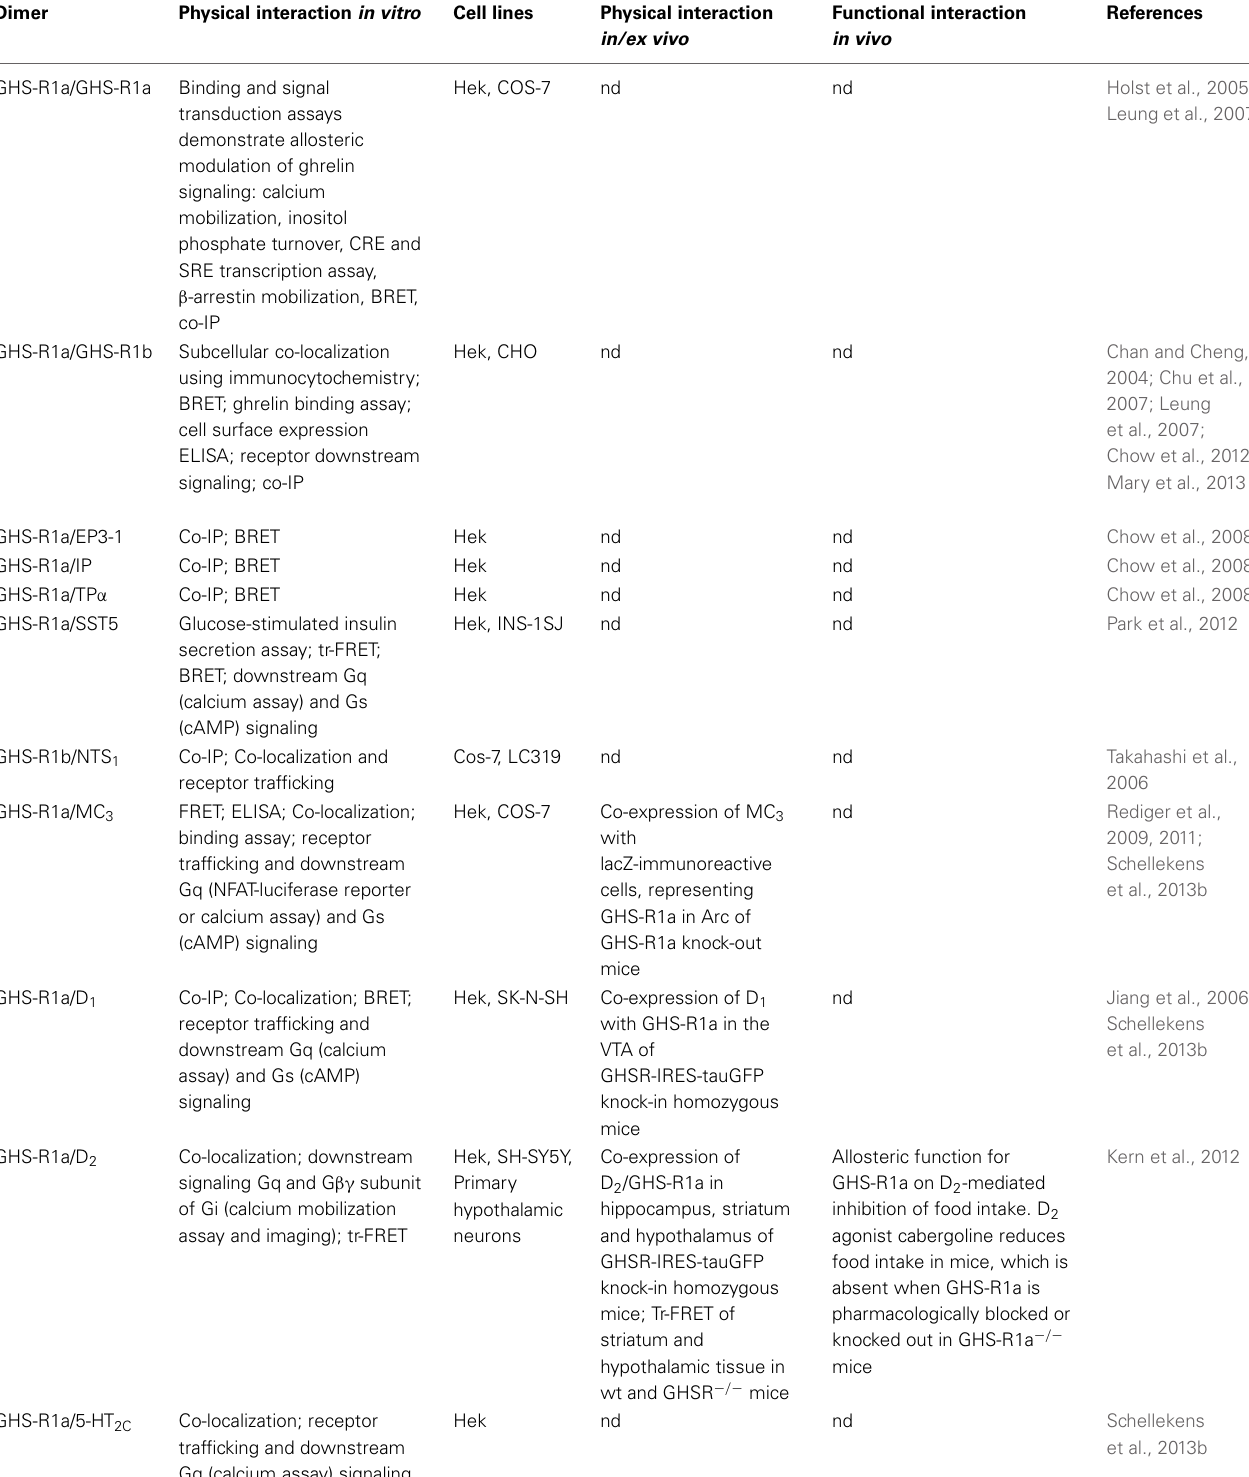
Table 1 | Homo- and heterodimerization of the GHS-R1a receptor.